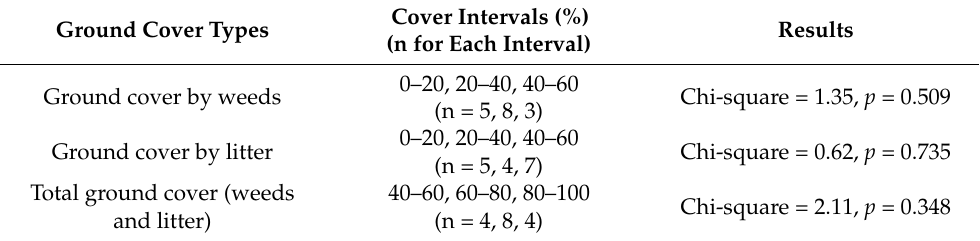
Figure 5. Extent of soil affected by erosion in relation to ground cover in maize cultivation plots. Values are mean ± standard error. Table 5. Kruskal–Wallis test of the relation between erosion and ground cover in maize cultivation plots (n =